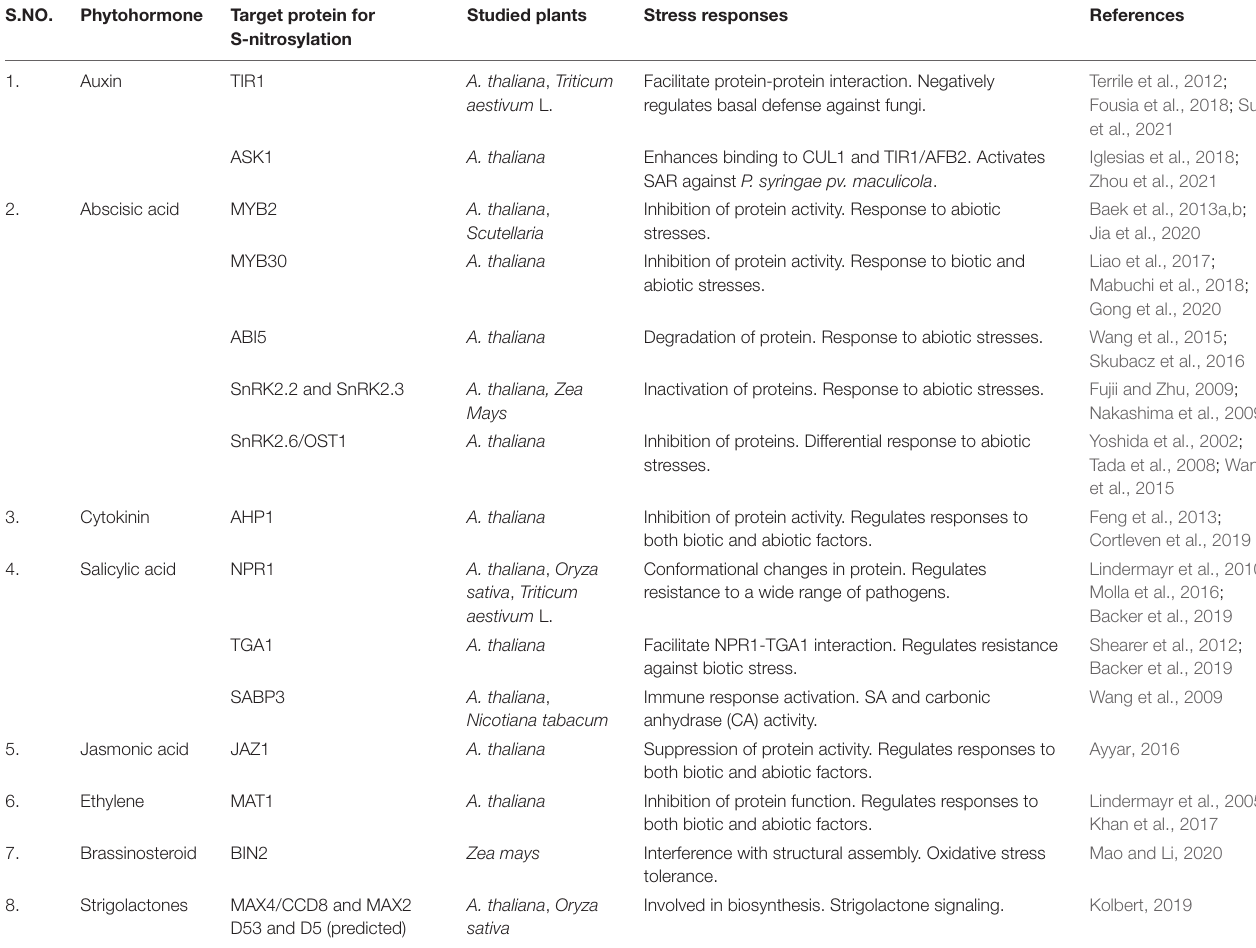
TABLE 1 | S-nitrosylation of target proteins involved in phytohormonal network.